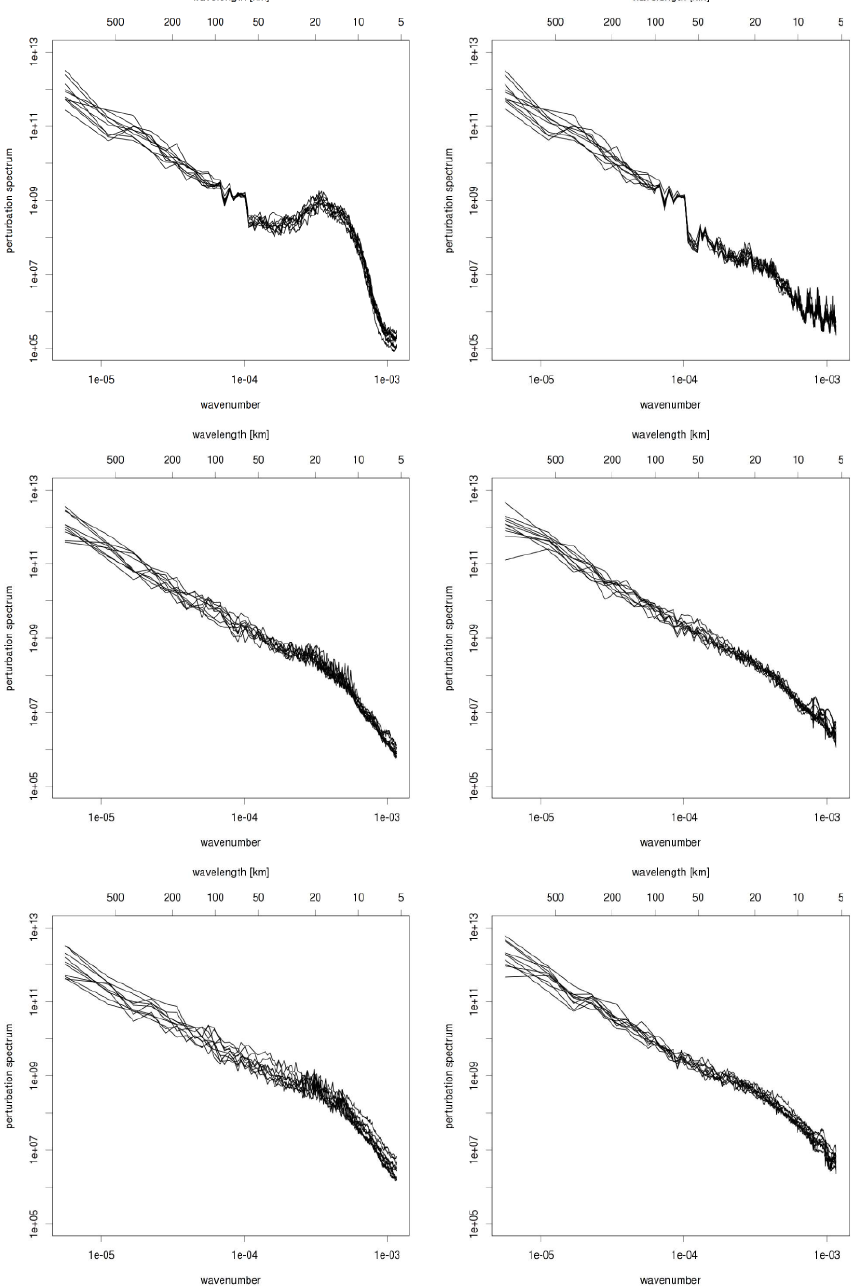
Fig. 5. Perturbation spectra of the field of geopotential at 500hPa for each member of COSMO-H2-EPS (left panels) and EXP-H2-EPS (right panels) at the initial time (top), and at +6h (middle) and +12h (bottom) forecast